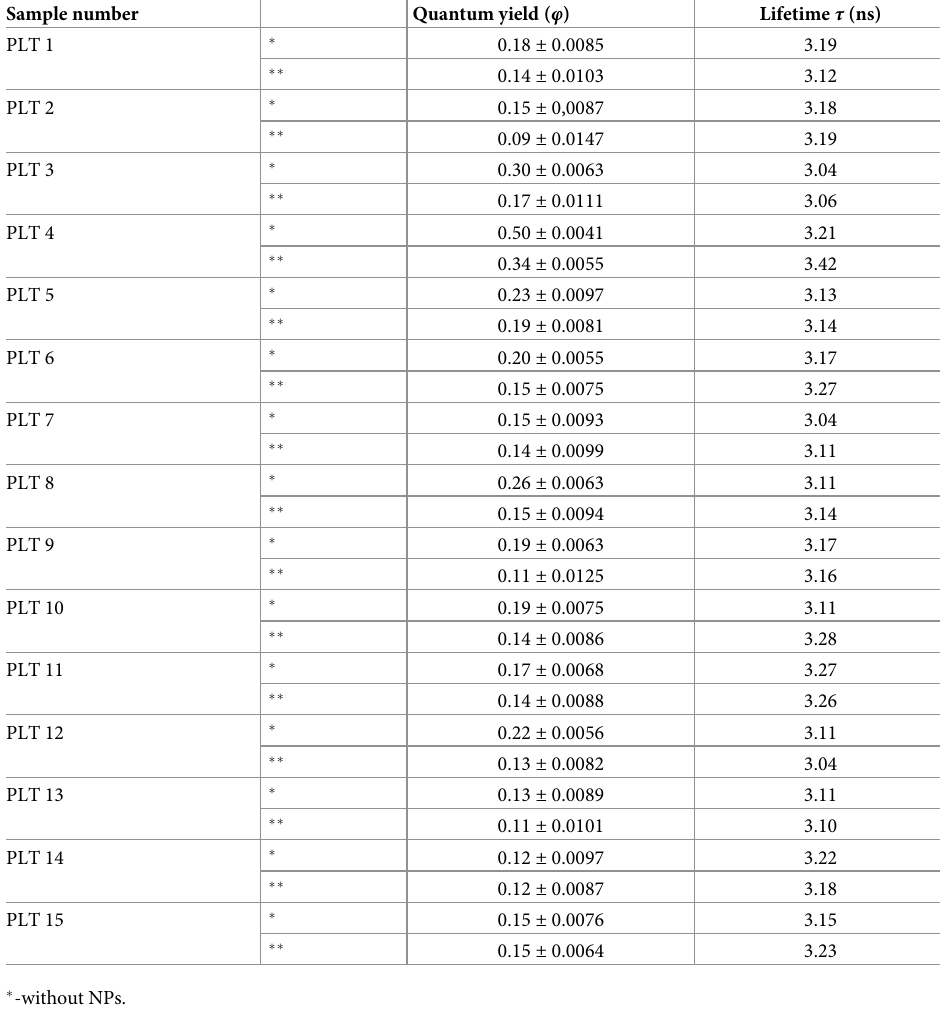
Table 2. Platelets fluorescence lifetime and quantum yield experimental